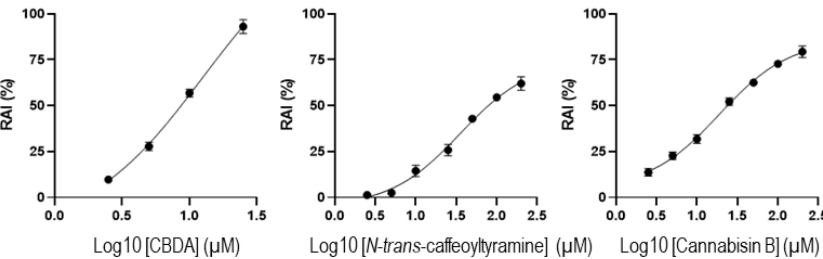
Figure 3. Mitochondrial Redox Activity Inhibition (RAI). SH cells were treated with cannabidiolic acid (CBDA), N - trans -caffeoyltyramine, or cannabisin B for 48 h, and RAI was assessed by MTT assay. Values are the mean ± SD of three independent experiments performed in triplicate. 3.3. Hemp Seed Metabolites Change the microRNA Expression Profiles of Neural Cells